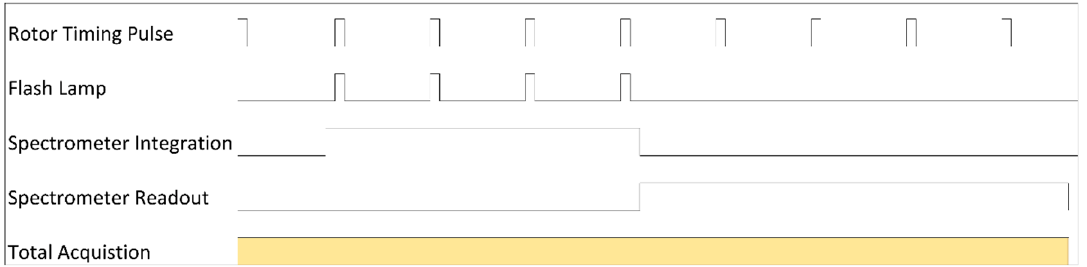
Figure A3. Synchronization timing diagram for 4 flash accumulation acquisition settings in a typical MWL-AUC data collection setup. Note: not drawn to scale.